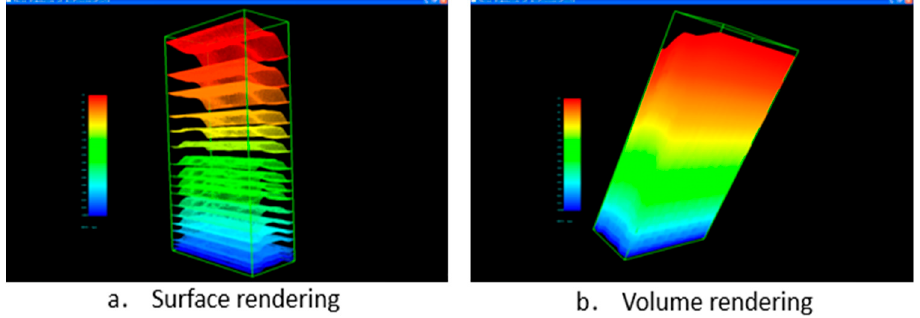
Figure 12. Visualization of NCEP pressure field data .